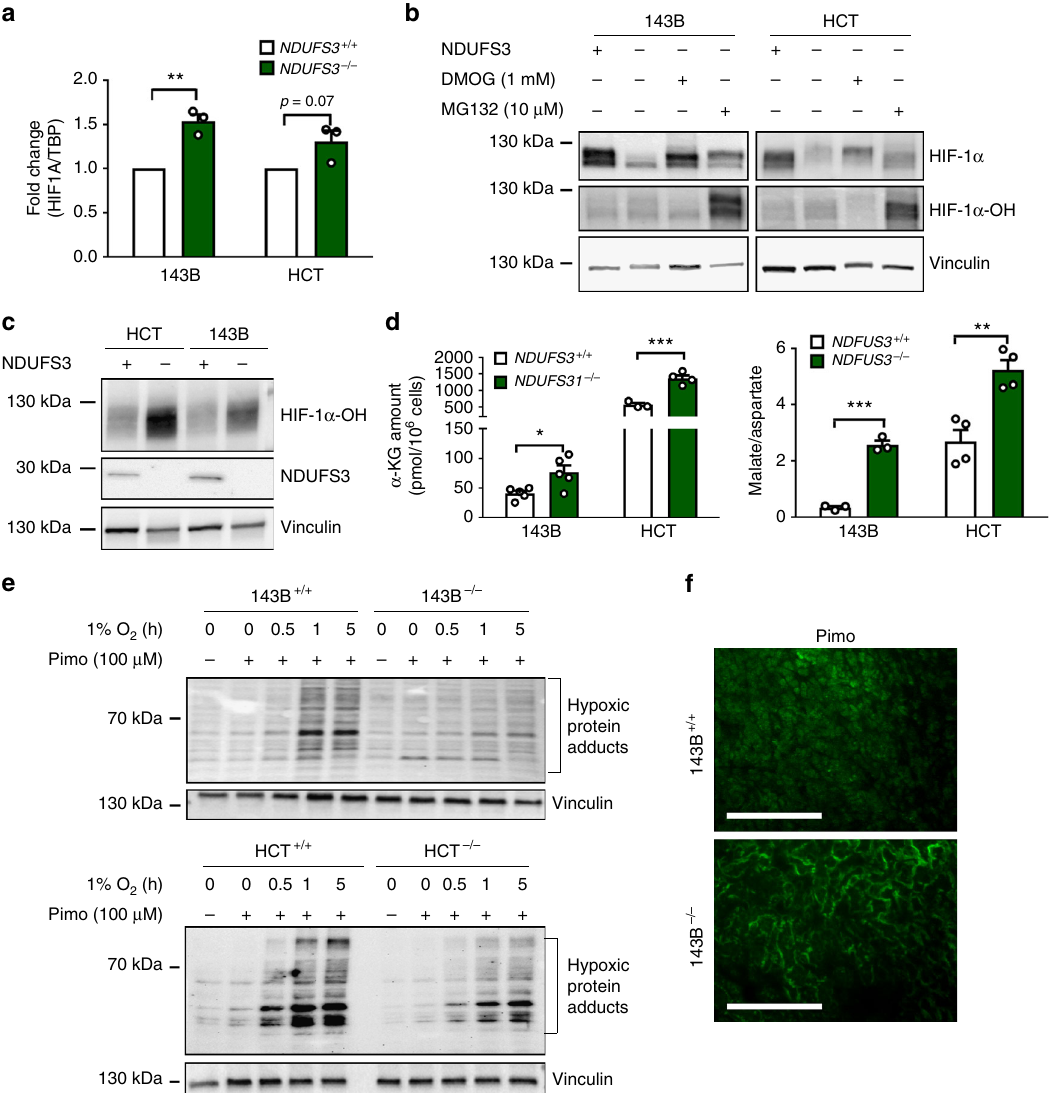
Fig. 4 CI de fi ciency induces HIF-1 α destabilization via increased PHD activity. a HIF1A expression level evaluated by qRT-PCR in 143B ( n = 3, df = 4, t = 5.2) and HCT ( n = 3, df = 4, t = 3.1) cells cultured for 5 h in 1% O 2 . Data are mean + s.e.m. b HIF-1 α and HIF-1 α -OH western blot analysis in 143B and HCT cells exposed to hypoxia (1% O 2 for 5 h) and treated with DMOG (1 mM for 3 h) or MG132 (10 µ M for 3 h). Vinculin was used as loading control. c HIF-1 α -OH and NDUFS3 western blot analysis in 143B and HCT cells exposed to hypoxia (1% O 2 for 5 h) and treated with MG132 (10 µ M for 3 h). Vinculin was used as loading control. d α -KG amount and malate/aspartate ratio in 143B [ n ( α -KG) = 2; n (malate/aspartate) = 3, df(malate/aspartate) = 4, t (malate/aspartate) = 14.3] and HCT [ n = 4, df = 6, t ( α -KG) = 6.8, t (malate/aspartate) = 4.8] cells measured under basal conditions. Data are mean + s.e.m. e Protein adducts western blot analysis in cells incubated with pimonidazole (Pimo) (100 µ M for 1 h). Vinculin was used as loading control. f Representative images of pimonidazole (Pimo) immuno fl uorescent staining in 143B xenografts. Scale bars: 100 µ m. In each panel, statistical signi fi cance is speci fi ed with asterisks (** p < 0.01, *** p <